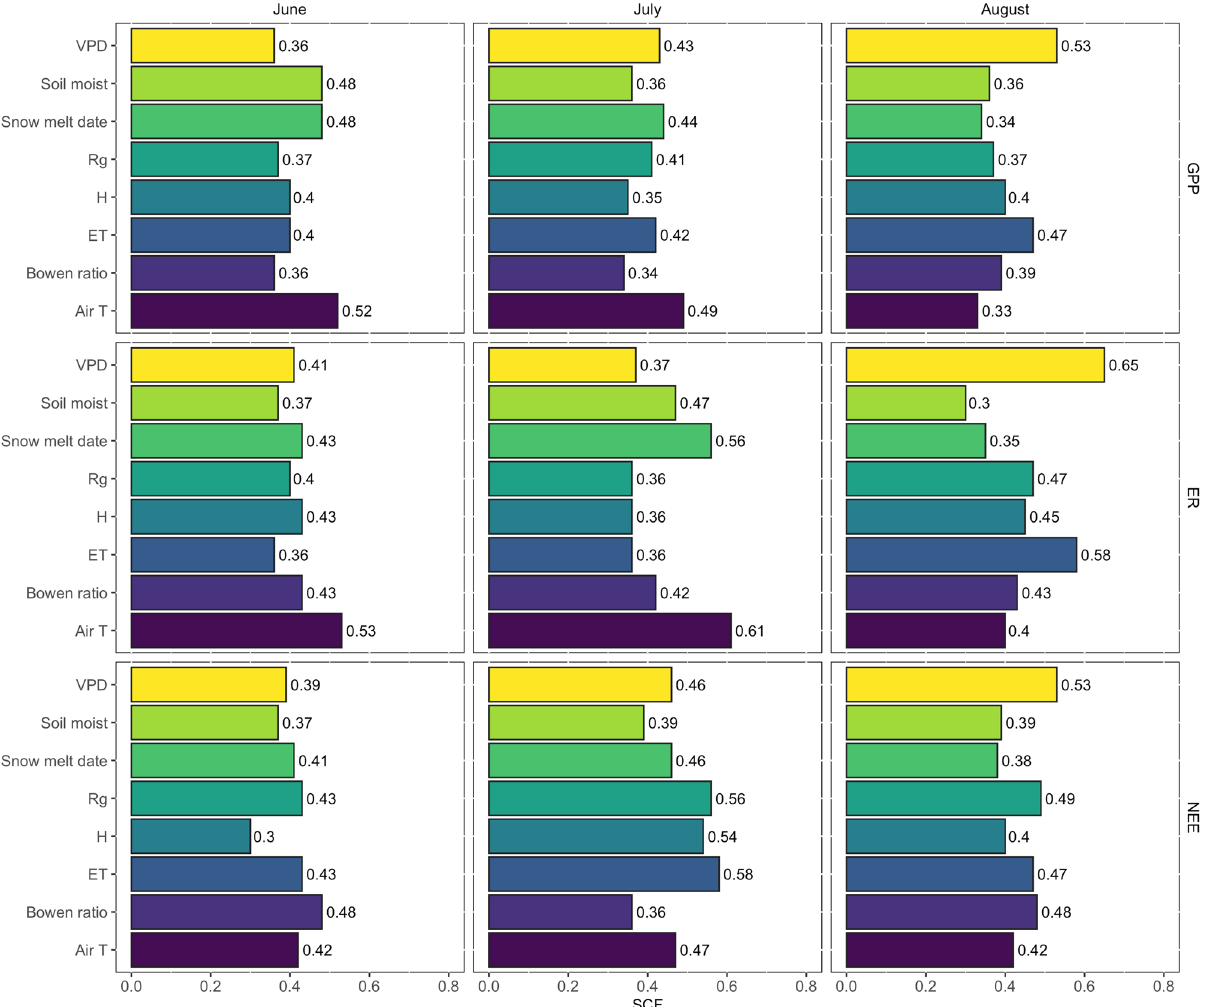
Figure 3. Squared covariance fraction (SCF) of each couple of the indicated variables for the maximum covariance analysis (MCA) of the monthly median anomalies of GPP, ER, and NEE in June, July, and August. The first pair of singular vectors are the phase-space directions when projected that have the largest possible cross-covariance. The singular vectors describe the patterns in the anomalies that are linearly correlated. A higher SCF indicates a stronger association over time between the indicated